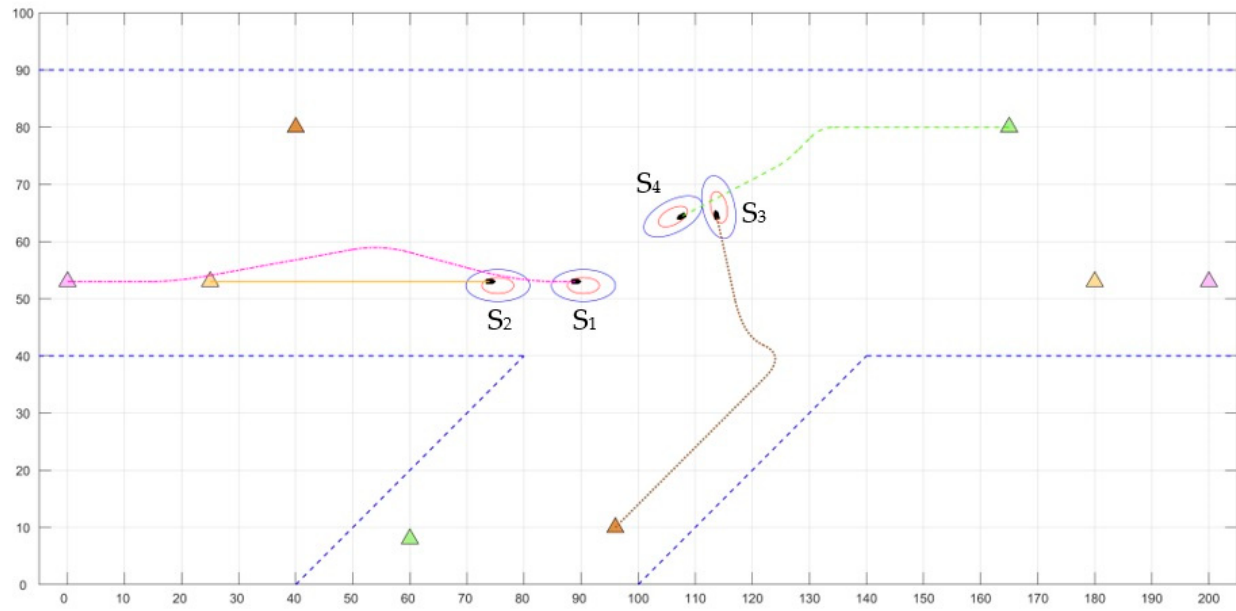
Figure 17. Scenario II of collision avoidance in a multi-ship situation.